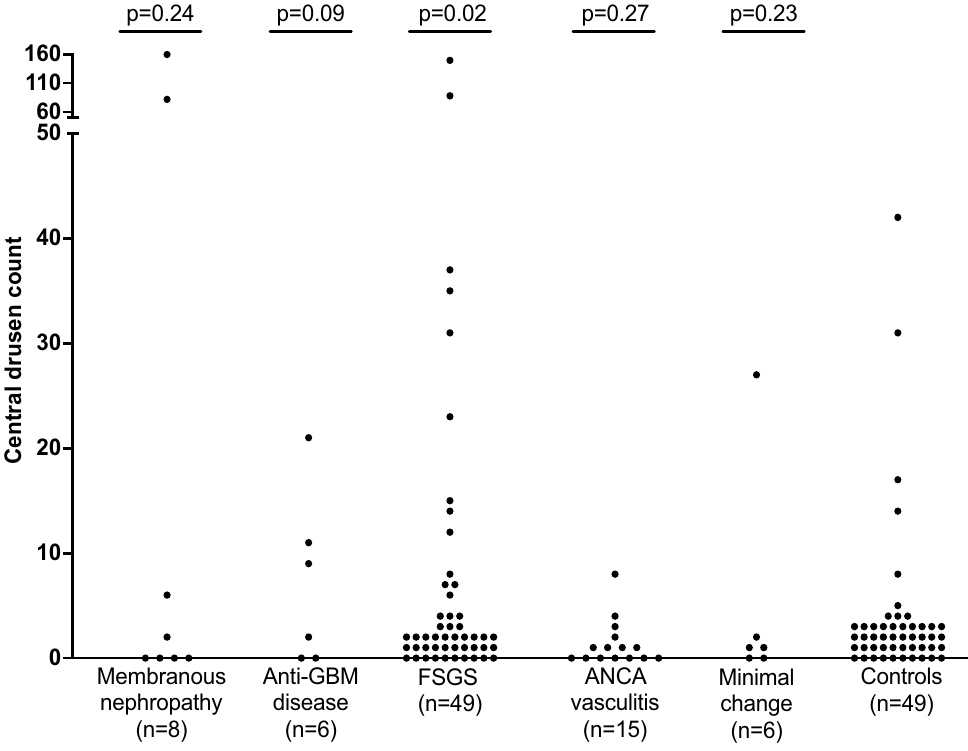
Figure 1. Drusen counts in different forms of glomerulonephritis and